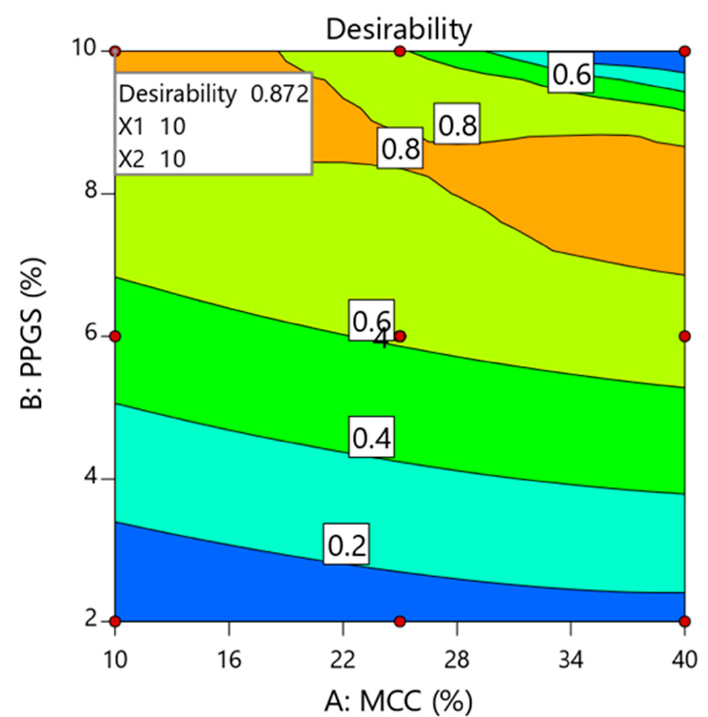
Figure 5. Formulation optimization using global desirability function. Table 11. Predicted and experimental values of optimized run with their relative errors.